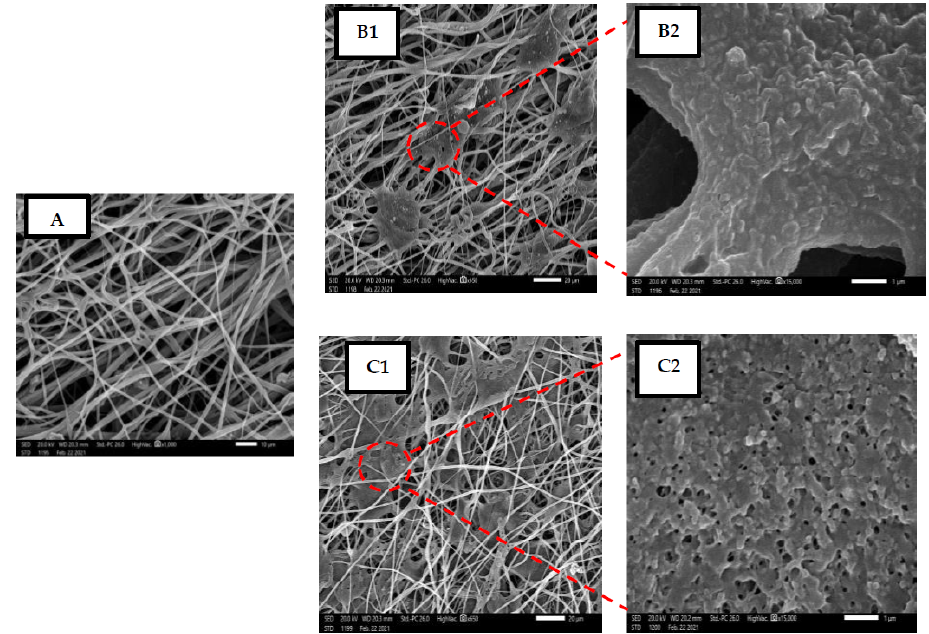
Figure 7. SEM image of the bacterial cell death in matrix of manufactured nanofibers where (A): Control untreated fibers, (B1): PVA-Ag 4%, (B2): Zoom of (B1) and (C1): TPU-Ag 4%, (C2): Zoom of (C1).